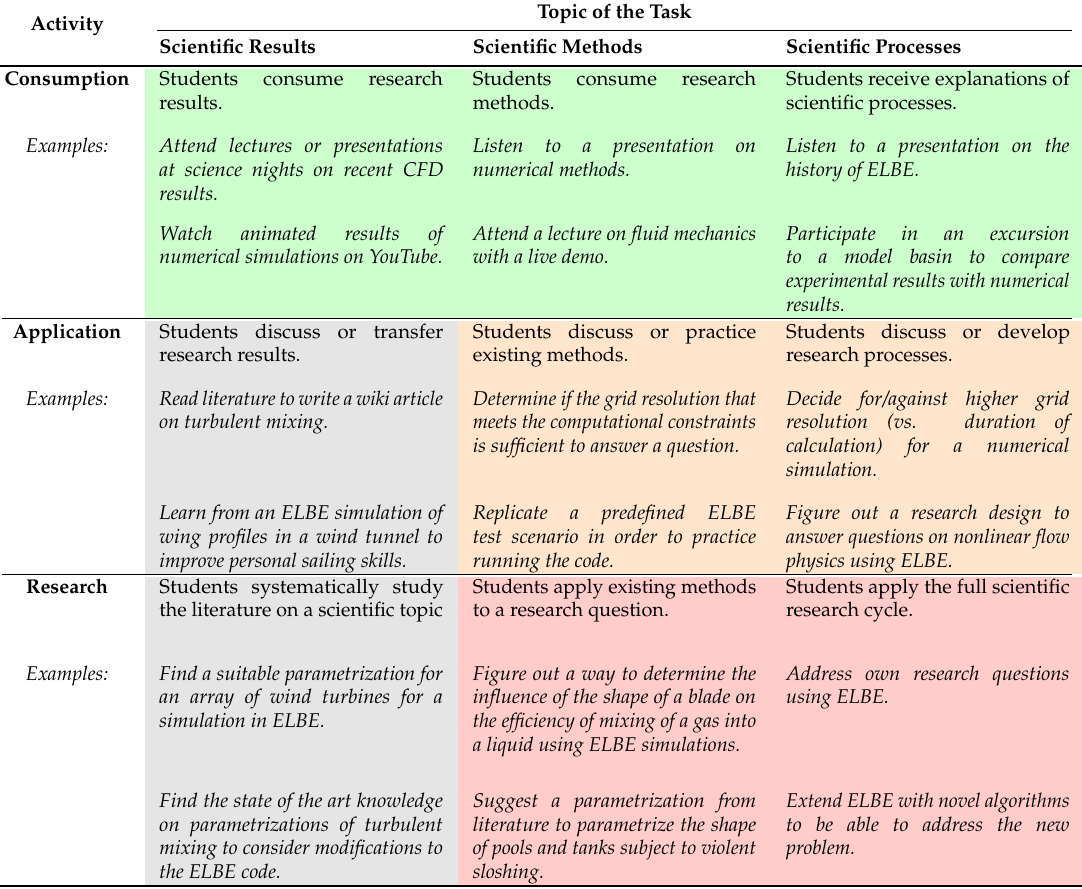
Table 2. Example tasks for different flavors of inquiry-based learning (based on Rueß (2013, [37]) and personal communication with Klaus Vosgerau and Timo Lüth